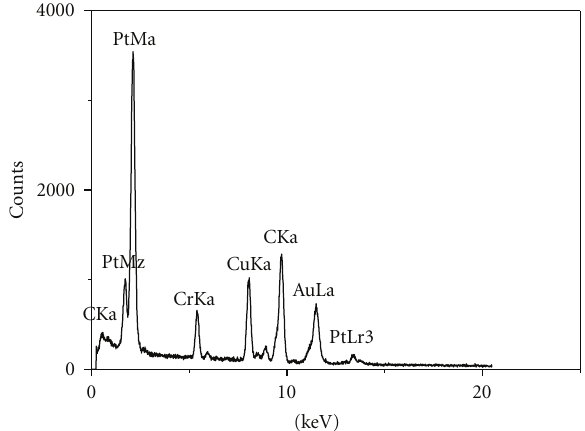
Figure 7: EDS spectra at the no. 2 point as indicated in Figure 6 (at the